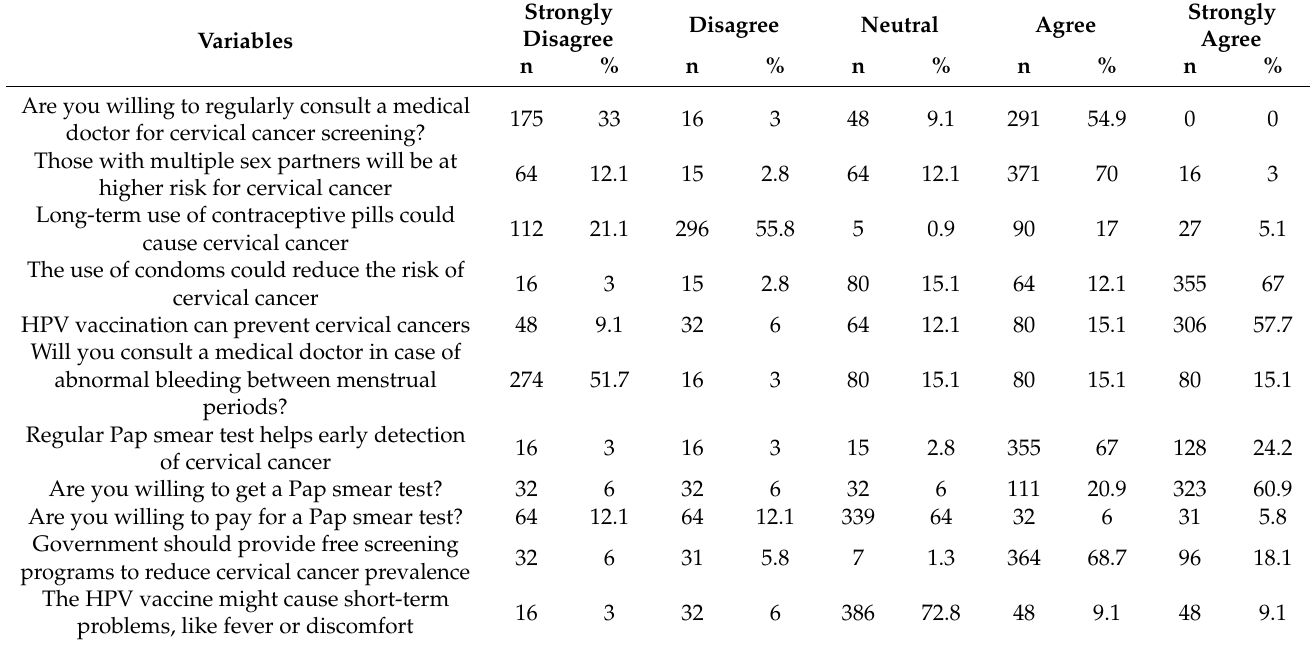
Table 3. Attitude-related questionnaire of the respondents on awareness, acceptance, and associated factors of human papillomavirus vaccine among parents of daughters in Hadiya zone, southern Ethiopia, 2021 (n = 530).